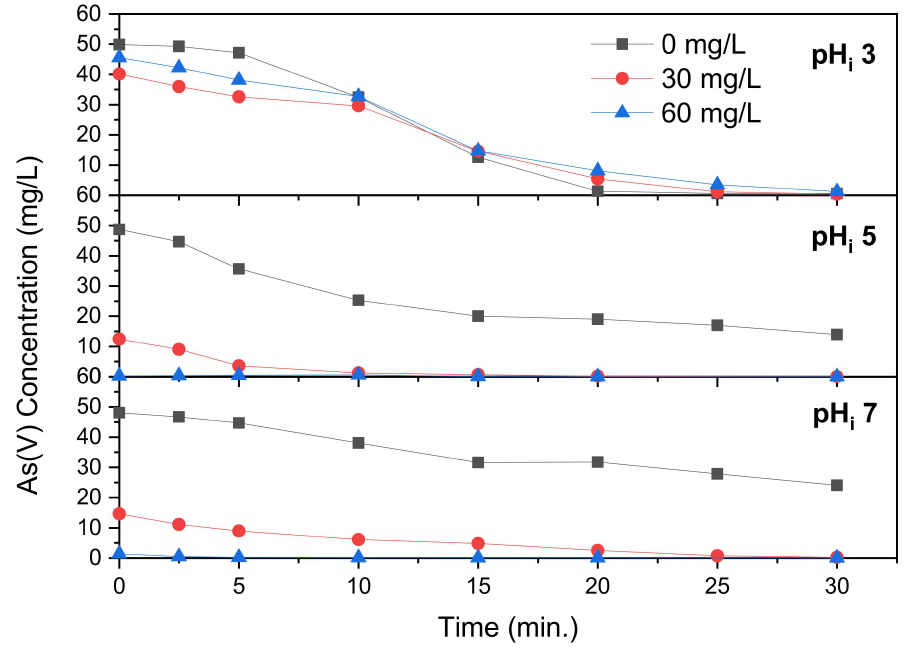
Figure 6. Arsenic removal over time through electrocoagulation assisted by varying concentrations of Al(III)